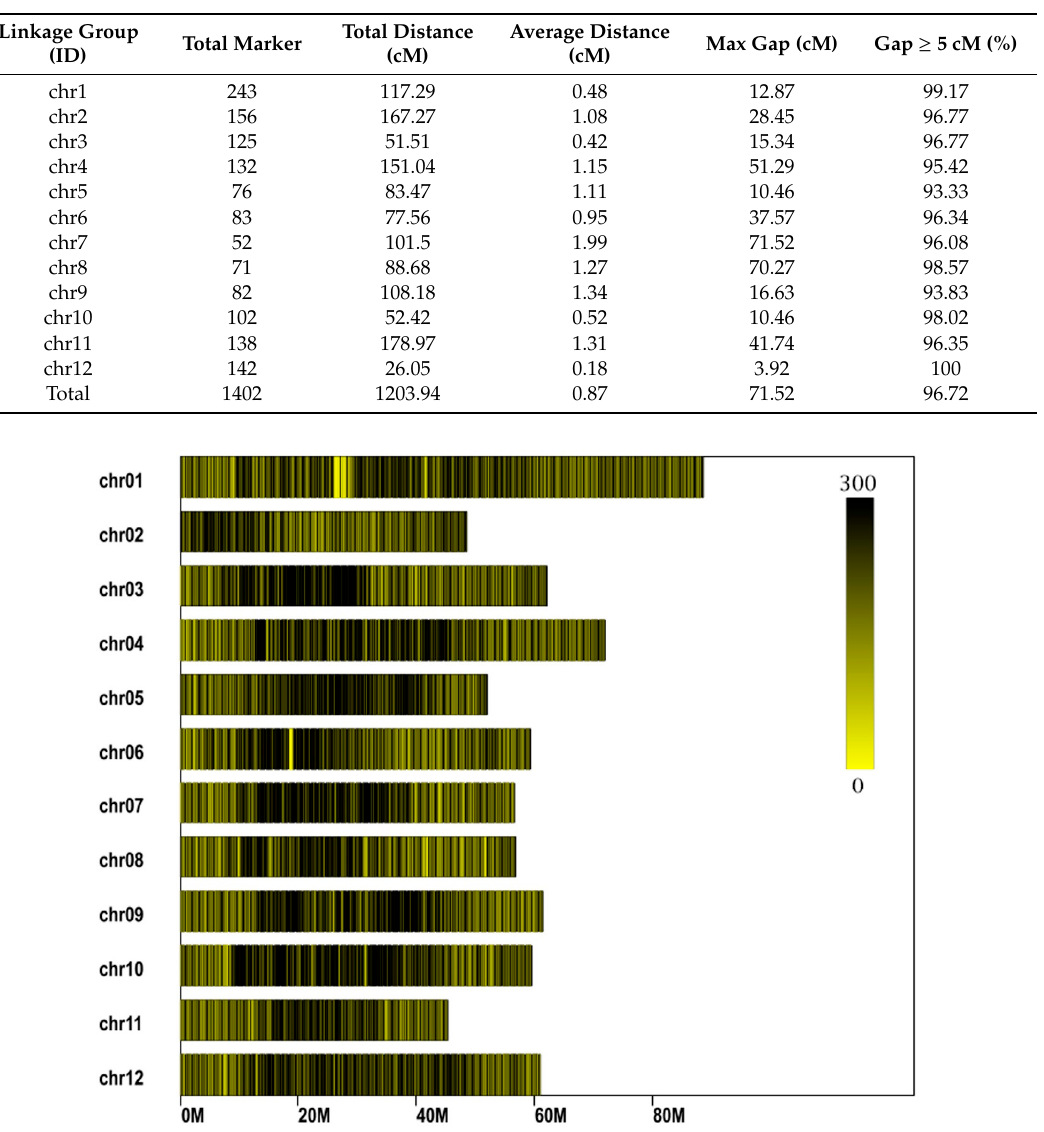
Figure A1. The SNP distribution on the potato genome. The x -axis represents the chromosome length and the y -axis indicates the chromosome code. Each band represents a chromosome, and the genome is divided according to the size of 1 M. The more SNPs in each band, the darker the color; the smaller the number of SNPs, the lighter the color. The darker areas in the figure are the areas where SNPs are concentrated.